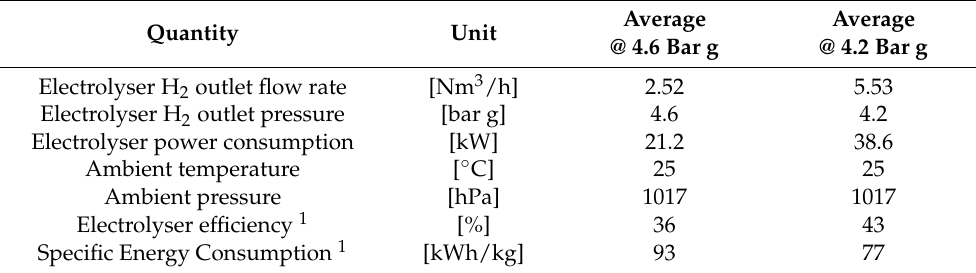
Average @ 4.6 Bar g @ 4.2 Bar g